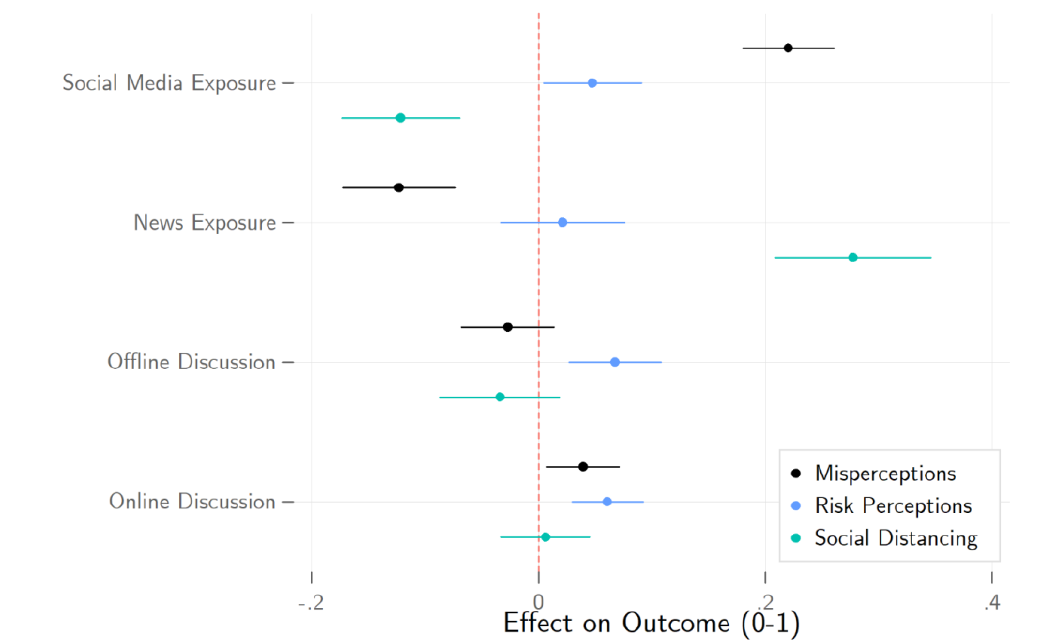
Figure 2. Effects of Media and Discussion on COVID-19 Misperceptions, Risk Perceptions, and Social Distancing Practice. Figure 2 plots the coefficients from three Ordinary Least Squares regression models. All measures scaled from 0-1, so effects can be interpreted as going from the minimum to the maximum of explanatory variables on the 0-1 scales of each outcome. Additional controls for income, education, age, gender, religiosity, language, and region not plotted. 95% confidence intervals